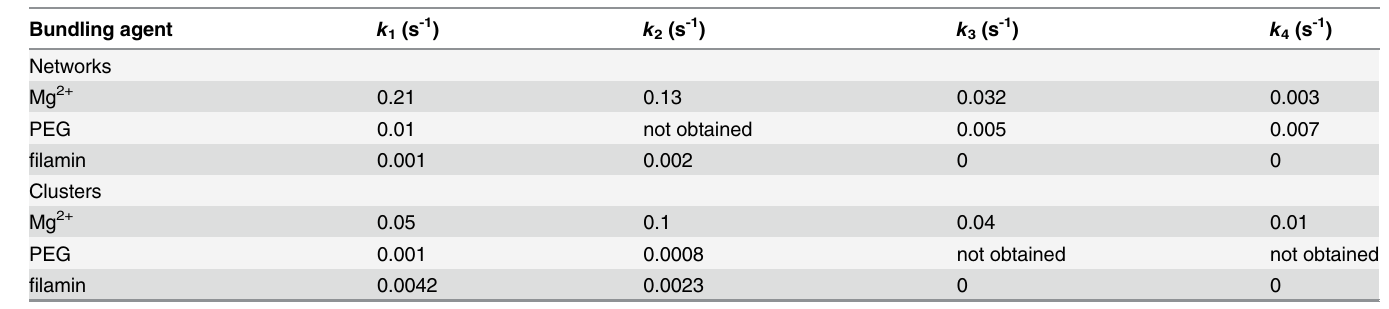
Table 1. Rate constants obtained for bundling and de-bundling reactions. Bundling